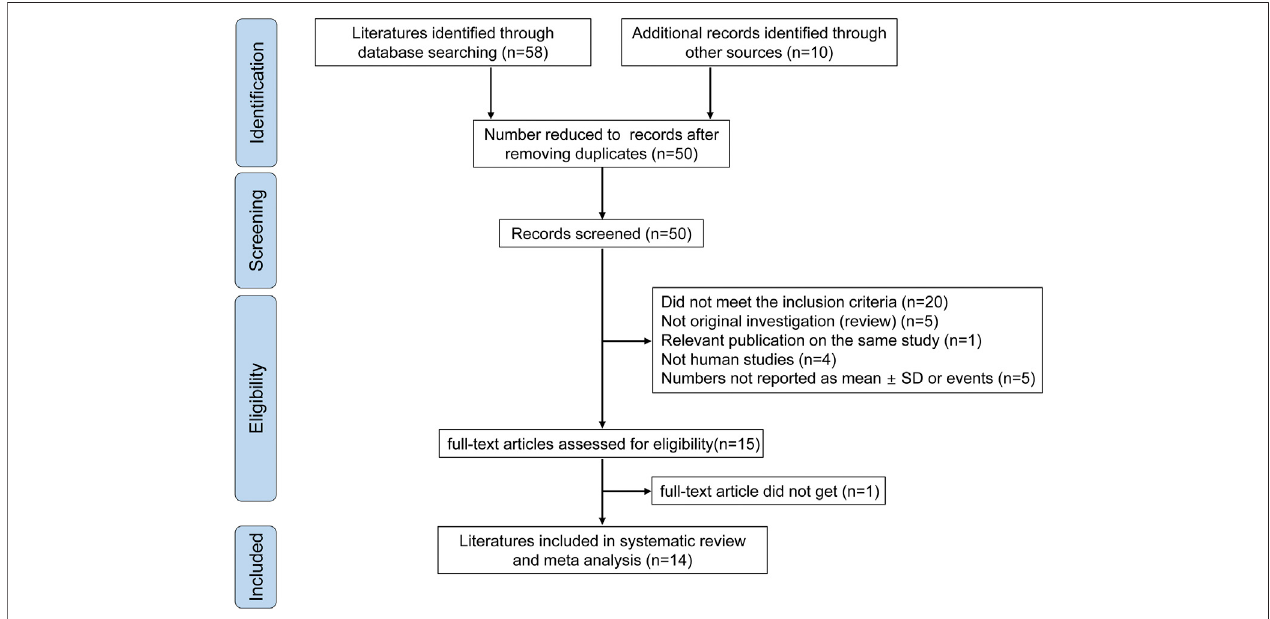
FIGURE 1 | Flowchart for article selection. The fl ow chart shows a literature search for probiotics on diarrhea and CD4 cell count in people living with HIV.